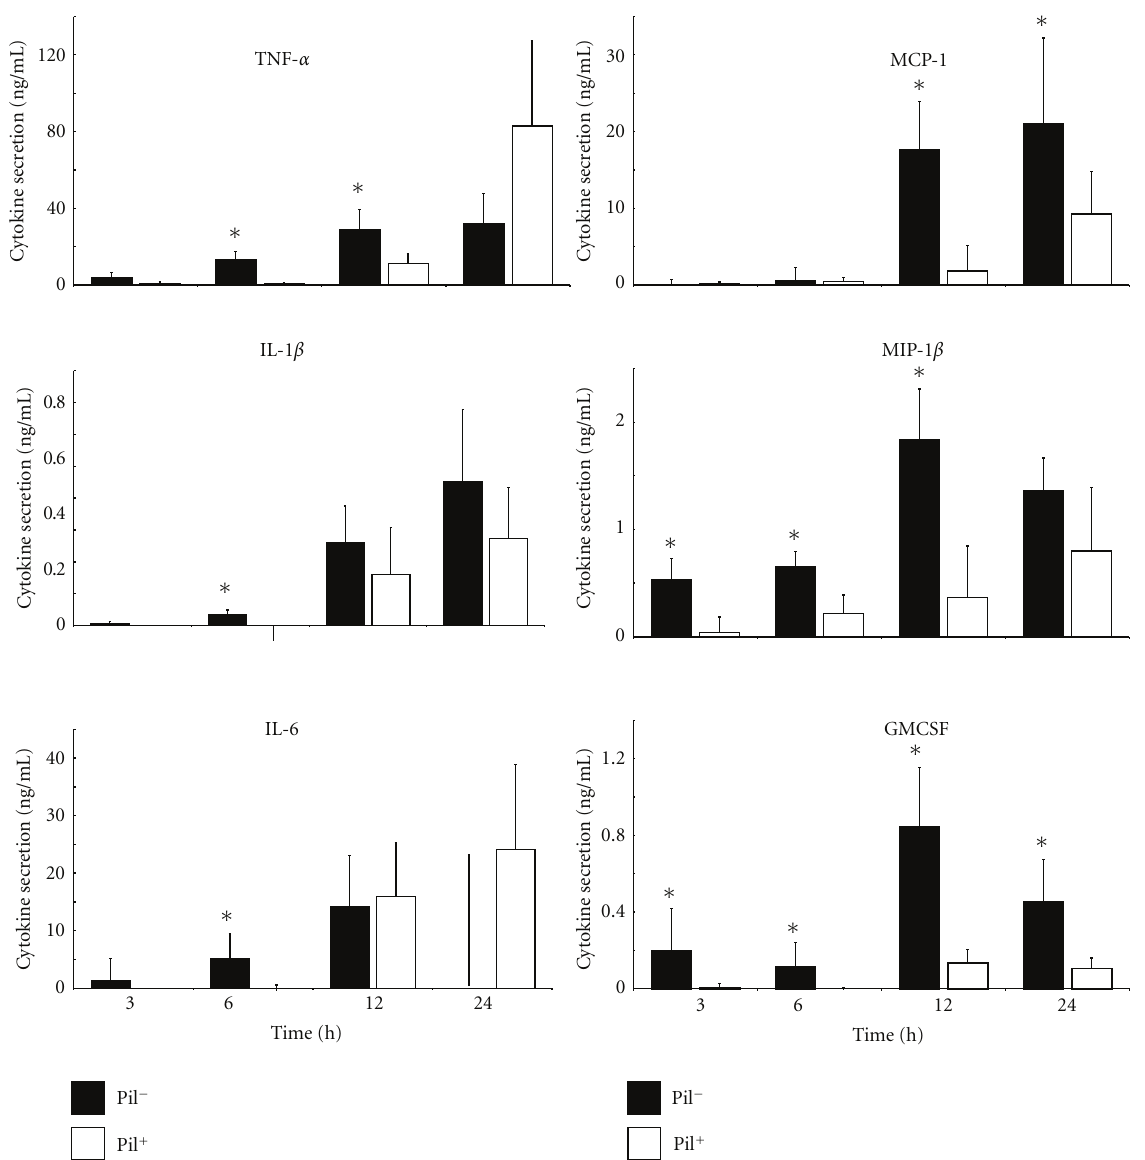
Figure 1: Expression of pilus attenuates cytokine production by human FT explant epithelium. FT explants were infected with Pil − Opa − NGO ( n = 7) and Pil + Opa − ( n = 6) and cytokine secretion measured over time. The columns represent mean cytokine levels and the standard error for the sample group. ∗ denotes statistically significant ( P < 0 . 05) increase in cytokine secretion induced by Pil − bacteria compared to Pil + bacteria at given time